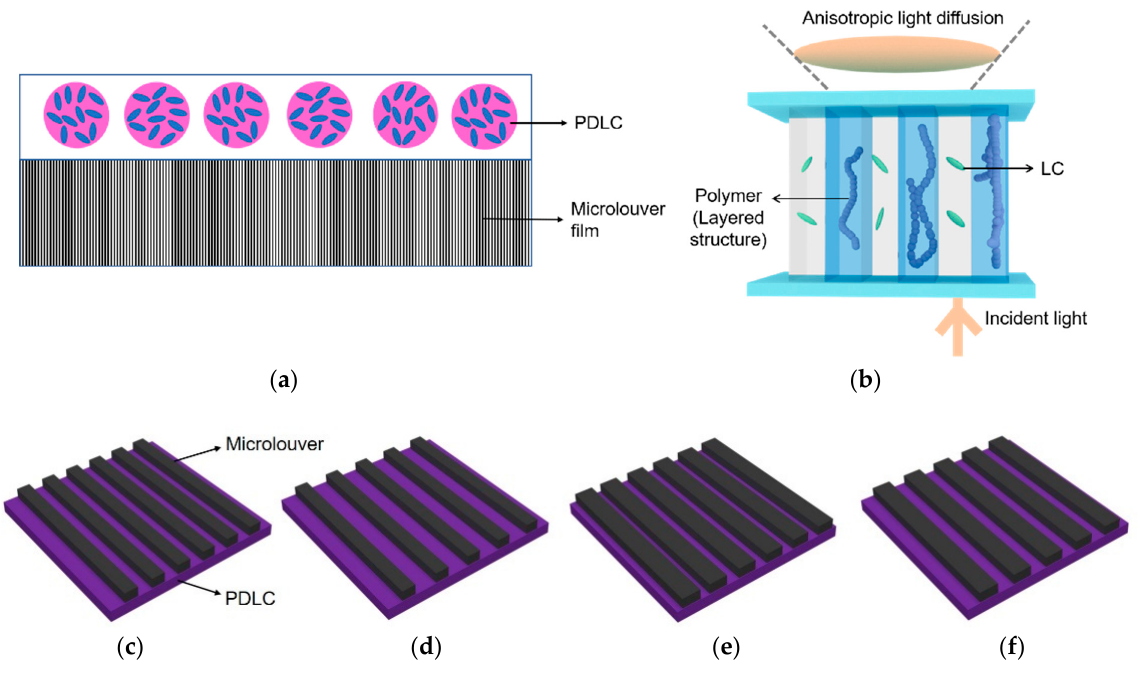
Figure 3. ( a ) Configuration structure and schematic mechanism of switchable anti-peeping film consists of 3M light control film and PDLC film; ( b ) schematic representation of PDLC having layered distribution of polymer network structure; ( c – f ) four microlouver structures with the same thickness, ( c ), 40–40 μ m, ( d ), 40–60 μ m, ( e ), 60–40 μ m, ( f ), 60–60 μ m, the first number represents the width of micro-stripe and the second number represents the space between two microstripes.